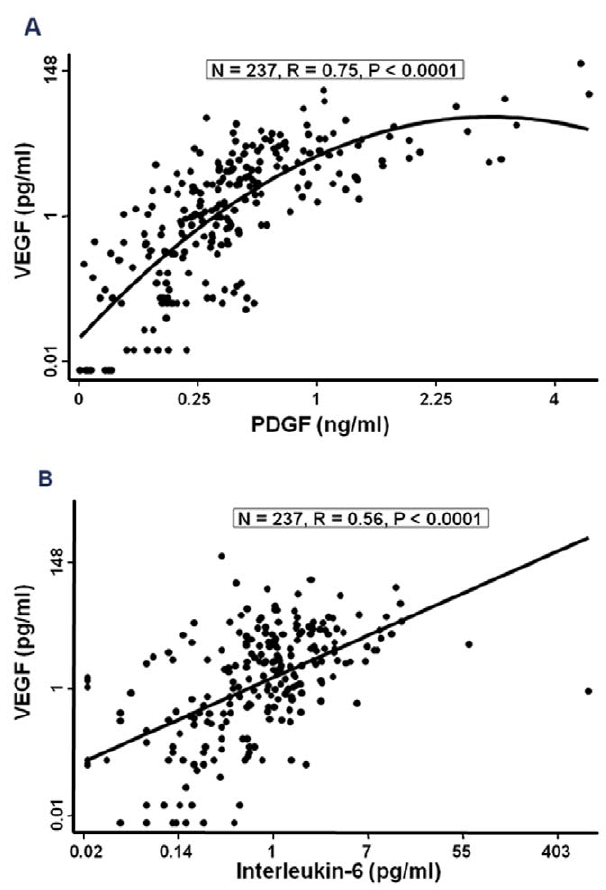
Figure 1. Bivariate relationships of VEGF with PDGF-BB and interleukin-6 in patients with sickle cell